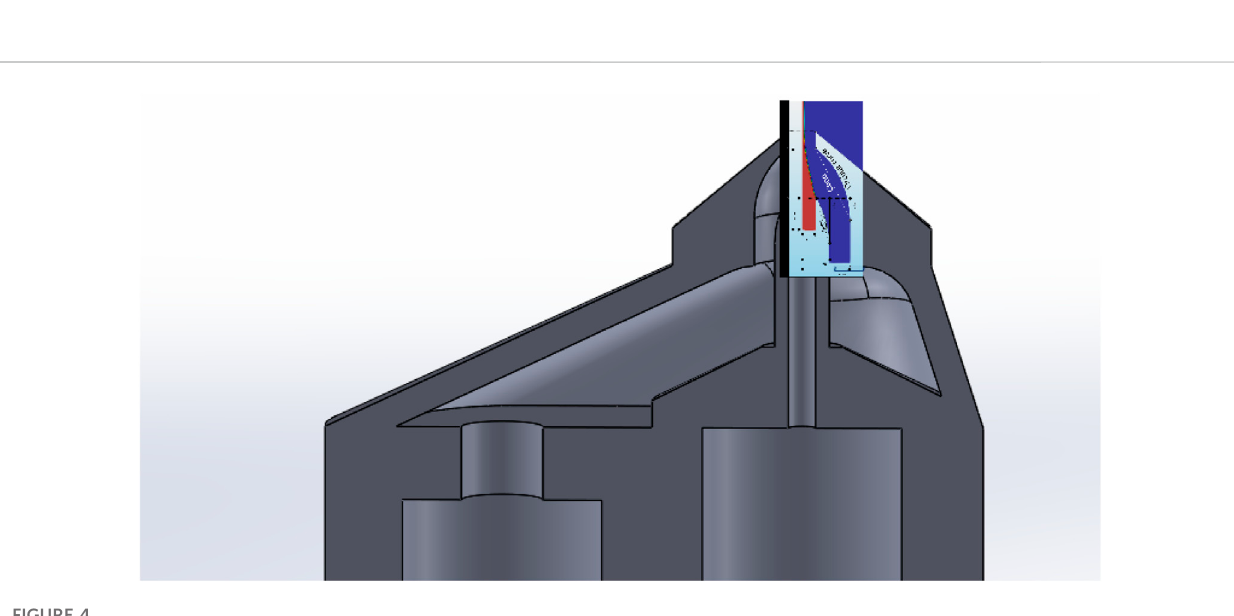
FIGURE 4 Geometry of the simulation superimposed on the sectioned view of the CAD of the manufactured